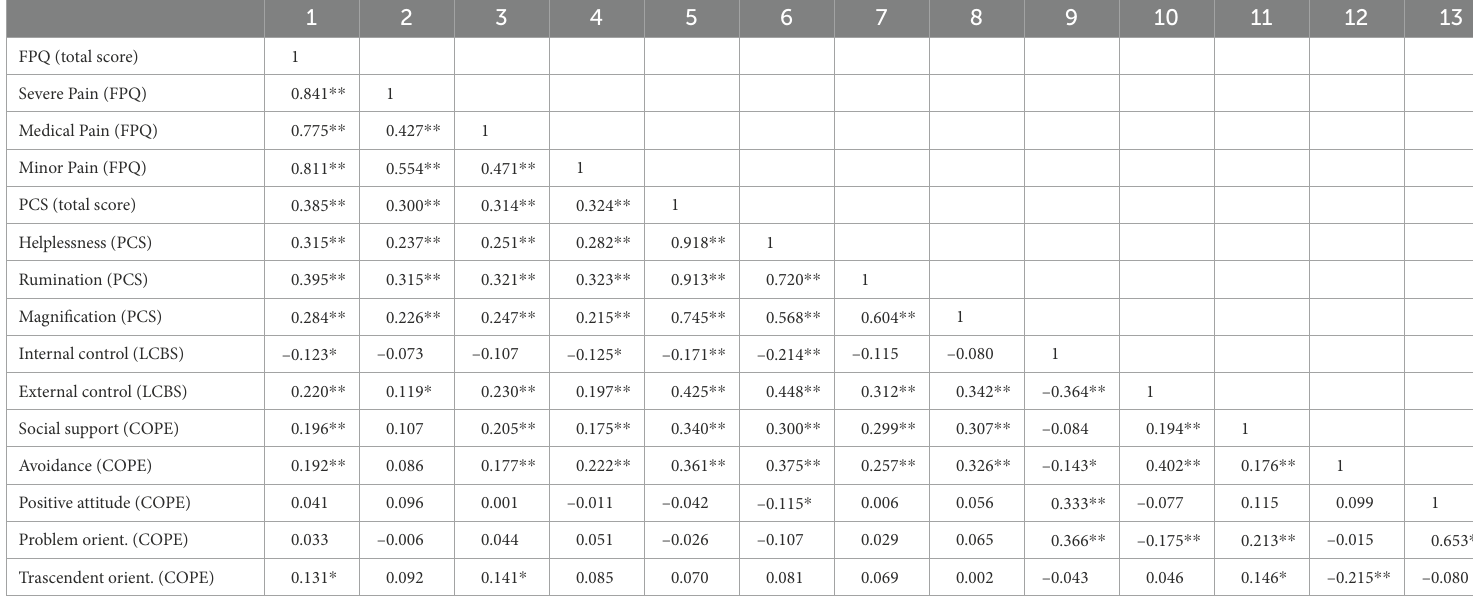
TABLE 8 Bivariate correlations between Brief FPQ-III, PCS, LCBS, and